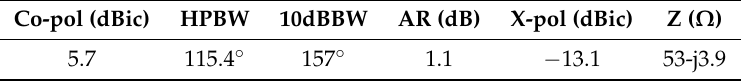
Figure 5. Simulation and measurement results of backfire helical antenna within operational bandwidth: ( a ) VSWR; ( b ) axial ratio; ( c ) directivity in co-polarization; and ( d ) polar plot of co- and cross-polarization at E-plane center frequency. Table 5. Summary of performance of backfire helix at center